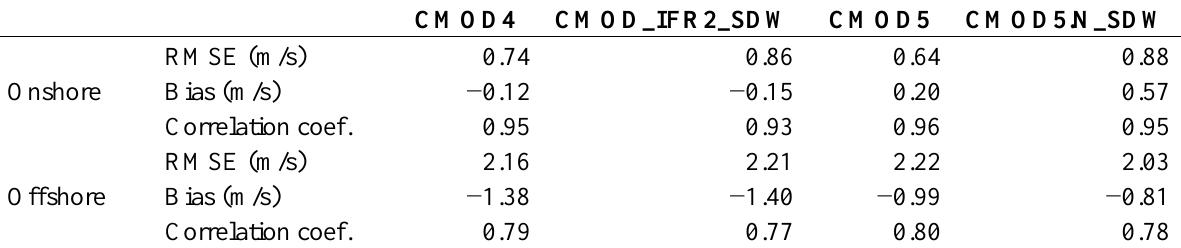
Table 2. RMSEs, biases and correlation coefficients of wind speeds retrieved by four GMFs at onshore and offshore